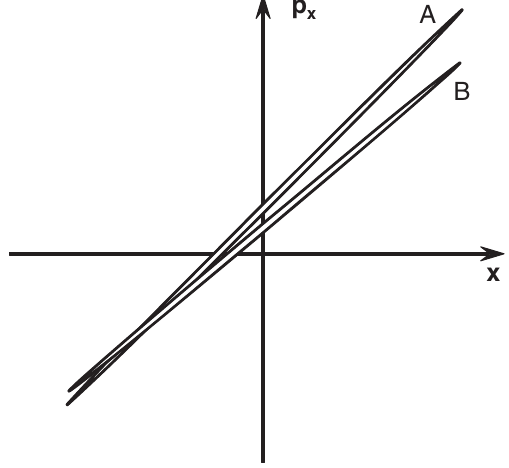
FIG. 15. Schematic distortion of the transverse phase space due to the time-dependent focusing of the rf field for the case of a beam starting with an offset relative to the rf field axis. Only two ellipses, A and B , indicating a slice in the head and in the tail of the bunch are shown. The other slices, which are filling the area between the head and the tail slice, are omitted for the sake of clarity.